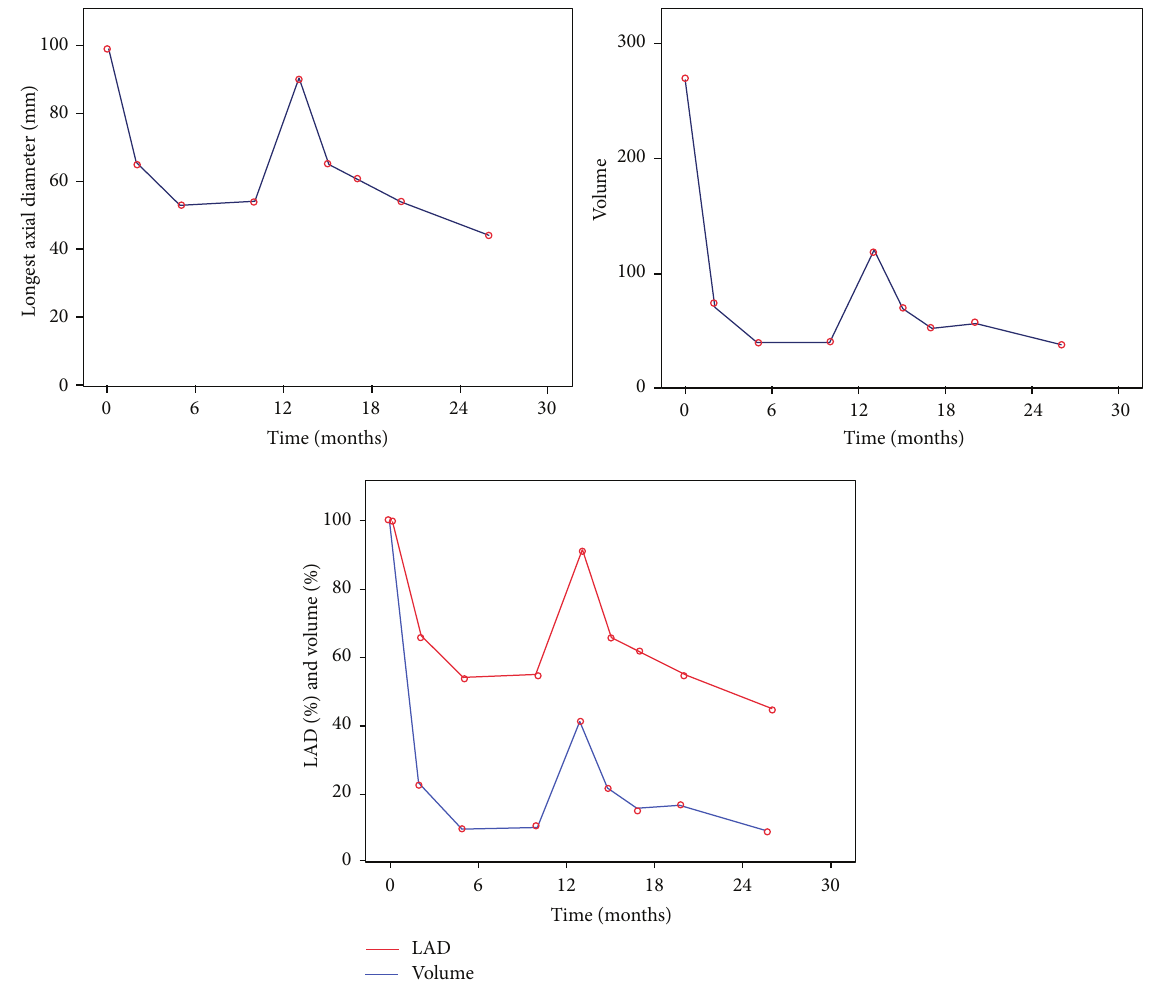
Figure 3: Changes of Longest Axial Diameter and volume (cm 3 ) during imatinib